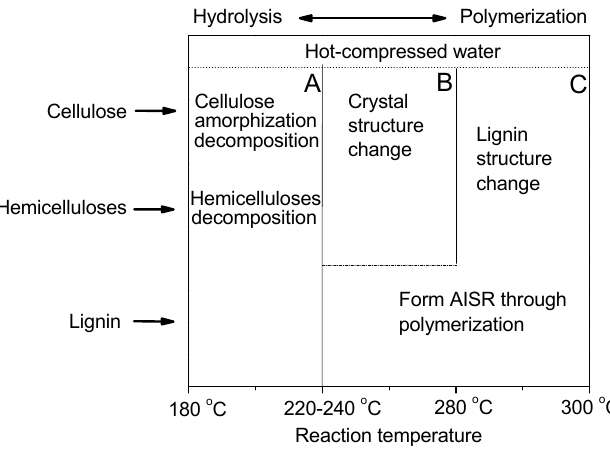
Figure 6. Mechanism for hydrothermal liquefaction of cypress.